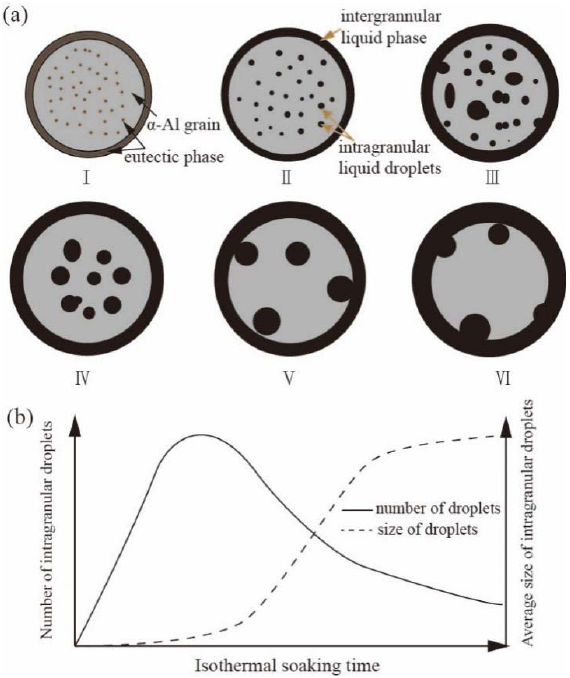
Figure 7. The evolution of intra ‐ granular liquid droplets, ( a ) schematic illustration of the evolution of intra ‐ granular droplets; ( b ) the variation of the number and average size of the intra ‐ granular liquid droplets during SSIT.